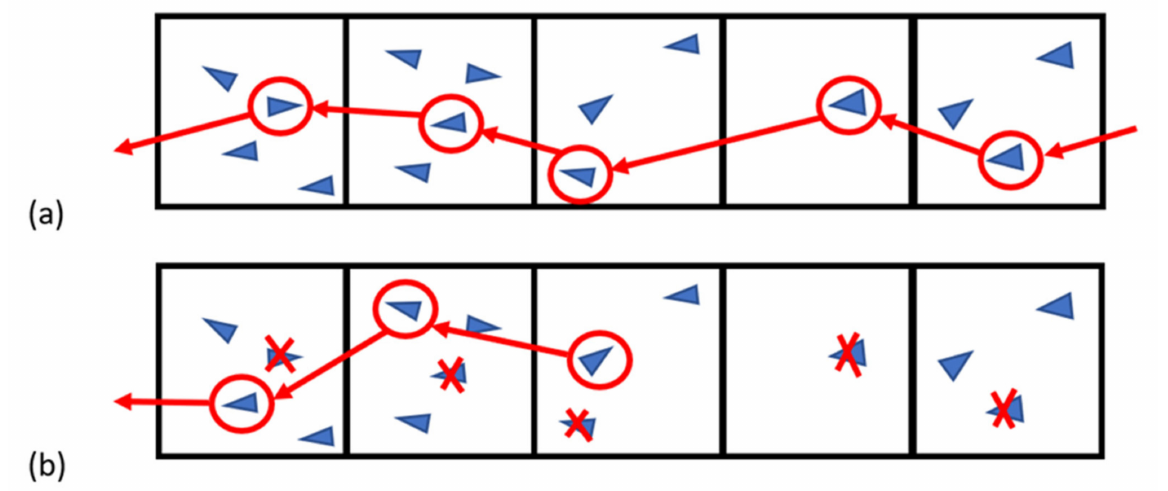
Figure 5. As seen in the cells that appear in part ( a ) of the figure, the simulator is able to form a channel between all the cells. Later, it will withdraw the ships involved in the channel. Then, in part ( b ) of the figure, the system tries to form another channel starting, once again, from the cell located on the right side. As there are no ships available in the second cell, the simulator starts with the cell next to the one that no longer has available